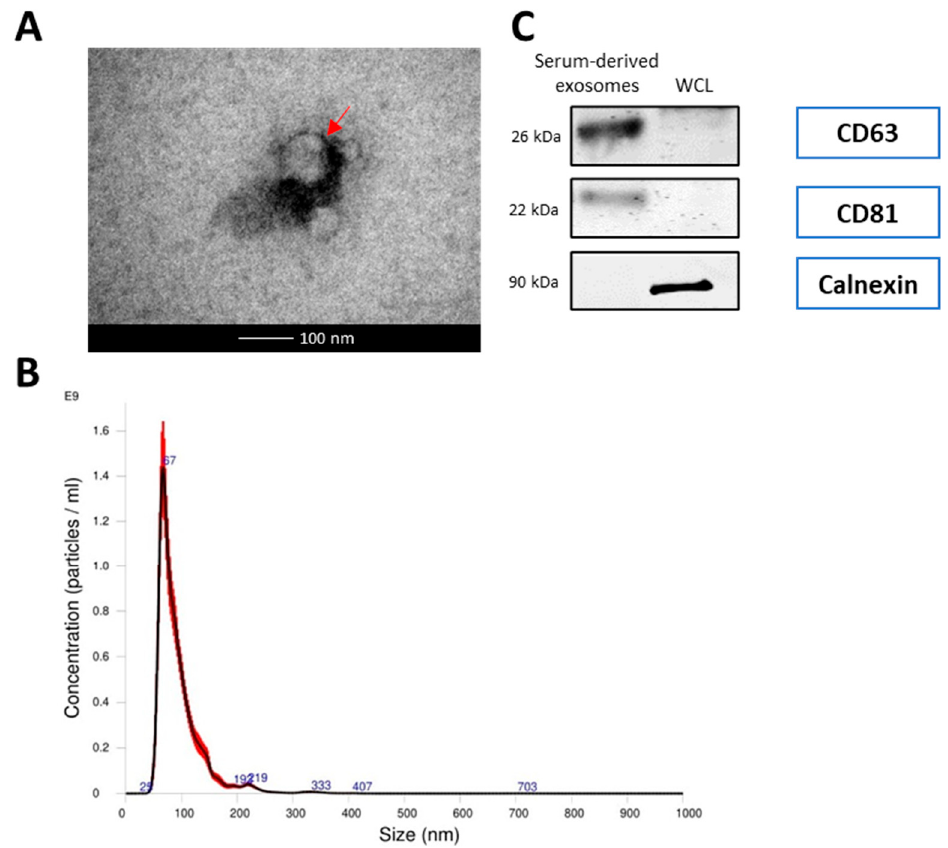
Figure 1. Characterization of serum exosomes ( A ) Transmission electron microscope (TEM) images of exosomes isolated from serum. The bar represents 100 nm. Red arrows indicate exosomes. ( B ) The size distribution of serum exosomes determined by nanoparticle tracking analysis (NTA). ( C ) Western blot analysis of exosome markers (CD63 and CD81) and negative markers (calnexin) in equivalent amounts of protein from serum exosomes and A549 whole cell lysates (WCL) (as a control). (Original whole Western-blot Images and densitometry reading in Figure 1 and Table